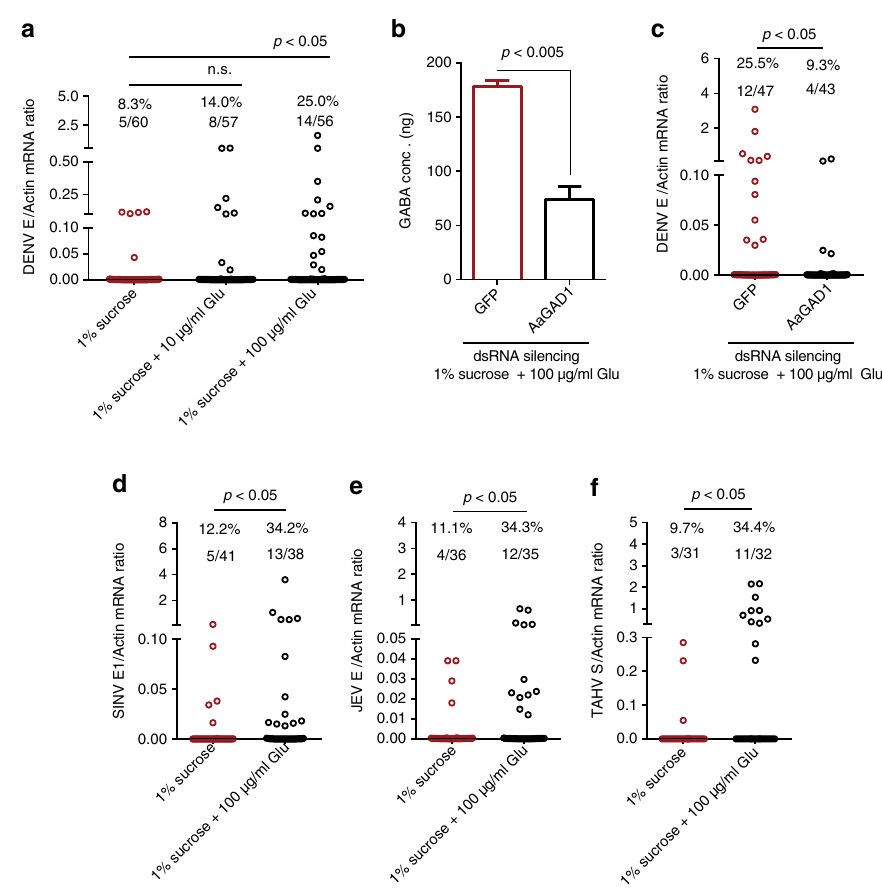
Fig. 6 Glutamate-mediated GABA generation facilitates infection of mosquito vectors by mosquito-borne viruses. a The oral introduction of glutamic acid enhanced the prevalence of DENV-2 infection in A. aegypti . A mixture, which contained 1% sucrose (500 µ l), supernatant from 6 × 10 5 p.f.u./ml of DENV- 2-infected Vero cells (cultured in serum-free medium) (500 µ l), and 10 µ g/ml or 100 µ g/ml glutamic acid, was used to feed A. aegypti via an in vitro blood feeding system. Mosquitoes fed this mixture without glutamic acid served as a negative control. b , c Knockdown of the AaGAD1 gene suppressed glutamate-mediated GABA generation b , resulting in reduced DENV infection c with sucrose feeding. AaGAD1 was silenced by inoculation with AaGAD1 dsRNA. Mosquitoes inoculated with GFP dsRNA served as negative controls. Three days post dsRNA treatment, a mixture that containing 1% sucrose (500 µ l), supernatant from DENV-2-infected Vero cells (cultured in serum-free medium) (500 µ l), and 100 µ g/ml glutamic acid, was used to feed A. aegypti via an in vitro blood feeding system. d – f Sucrose feeding with glutamic acid enhanced the prevalence of SINV infection in A. aegypti d , JEV infection in C. pipiens pallens e and TAHV infection in C. pipiens pallens f . A mixture, which contained 1% sucrose (500 µ l), supernatant from either 2 × 10 6 p.f.u. ml − 1 of SINV-infected d , 5 × 10 5 p.f.u./ml of JEV-infected e and 5 × 10 6 p.f.u./ml of TAHV-infected f Vero cells (cultured in serum-free medium) (500 µ l), and 100 µ g/ml glutamic acid, was used to feed mosquitoes via an in vitro blood feeding system. Mosquitoes fed on this mixture without glutamic acid served as negative controls. b The numbers on the Y -axis represents the amount of GABA inoculated per mosquito. The results were reproduced twice. a , c – f Mosquito infectivity was determined by TaqMan qPCR or SYBR Green at 8 days post-blood meal. The number of infected mosquitoes relative to the total numbers of mosquitoes is shown at the top of each column. Each dot represents one mosquito. The data upper mosquito number are represented as the percentage of mosquito infection. Differences in the mosquito infective ratios were compared using Fisher ’ s exact test. a – f The data from at least